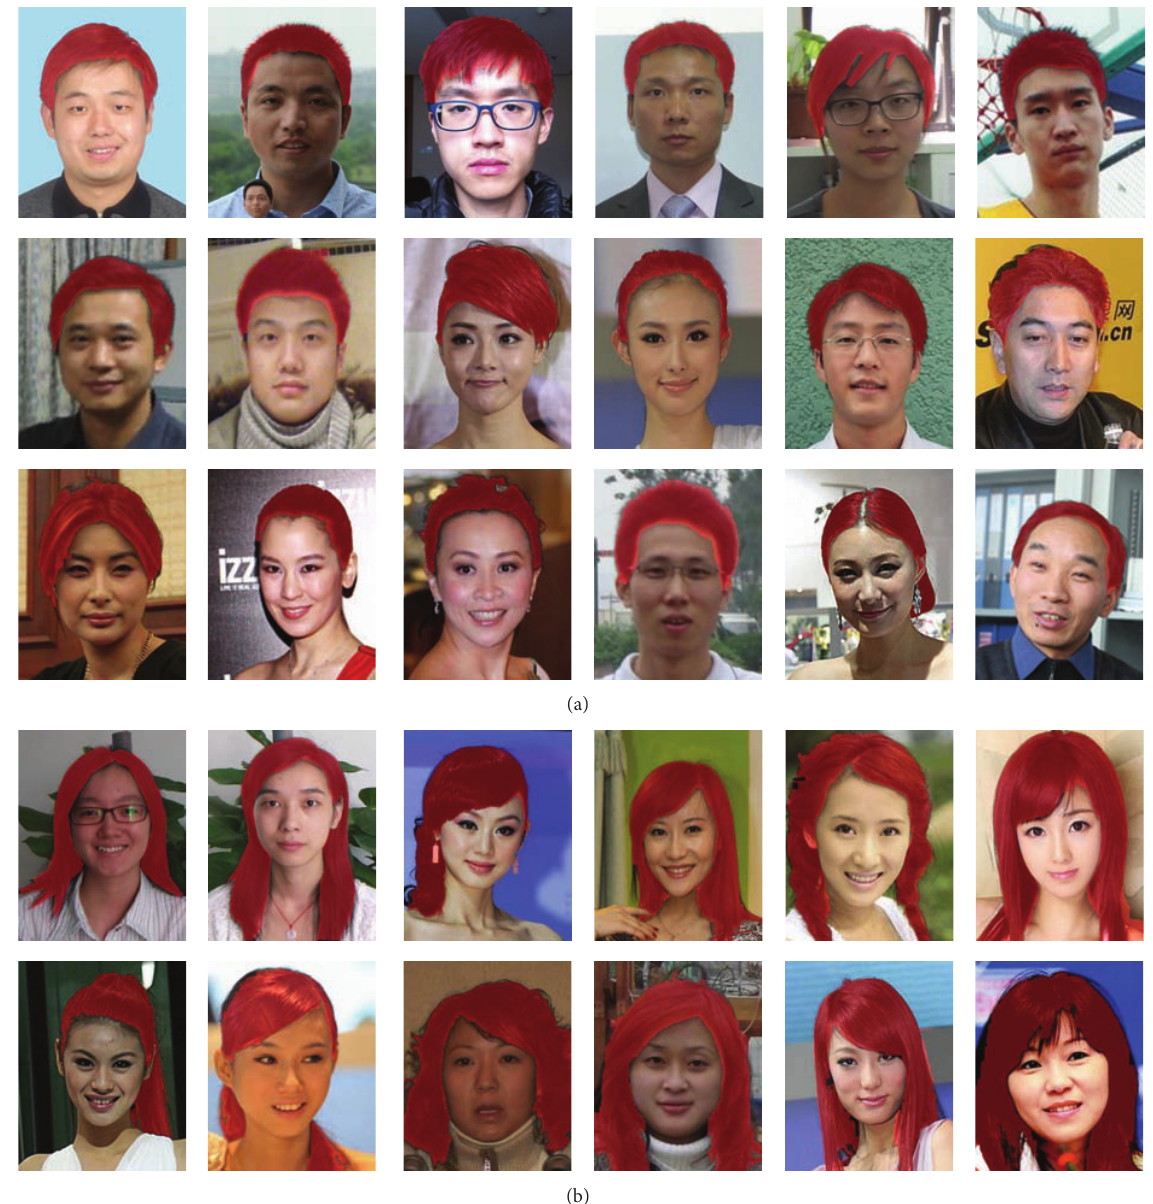
Figure 8: Examples of hair region detection results of our proposed method. The first 3 rows are short hair results and the remaining 2 rows are long hair results. Hair regions are labeled in light